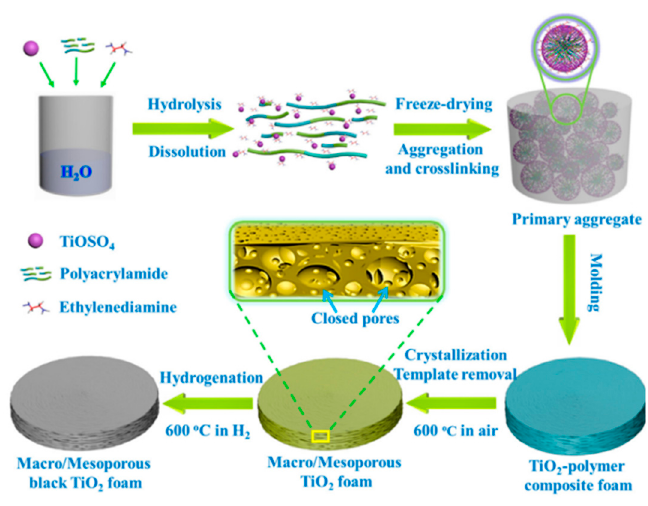
Figure 9. Scheme of the formation of self-floating amphiphilic macro/mesoporous black TiO 2 foams. Reprinted with permission from [54]. Copyright 2017, Elsevier.